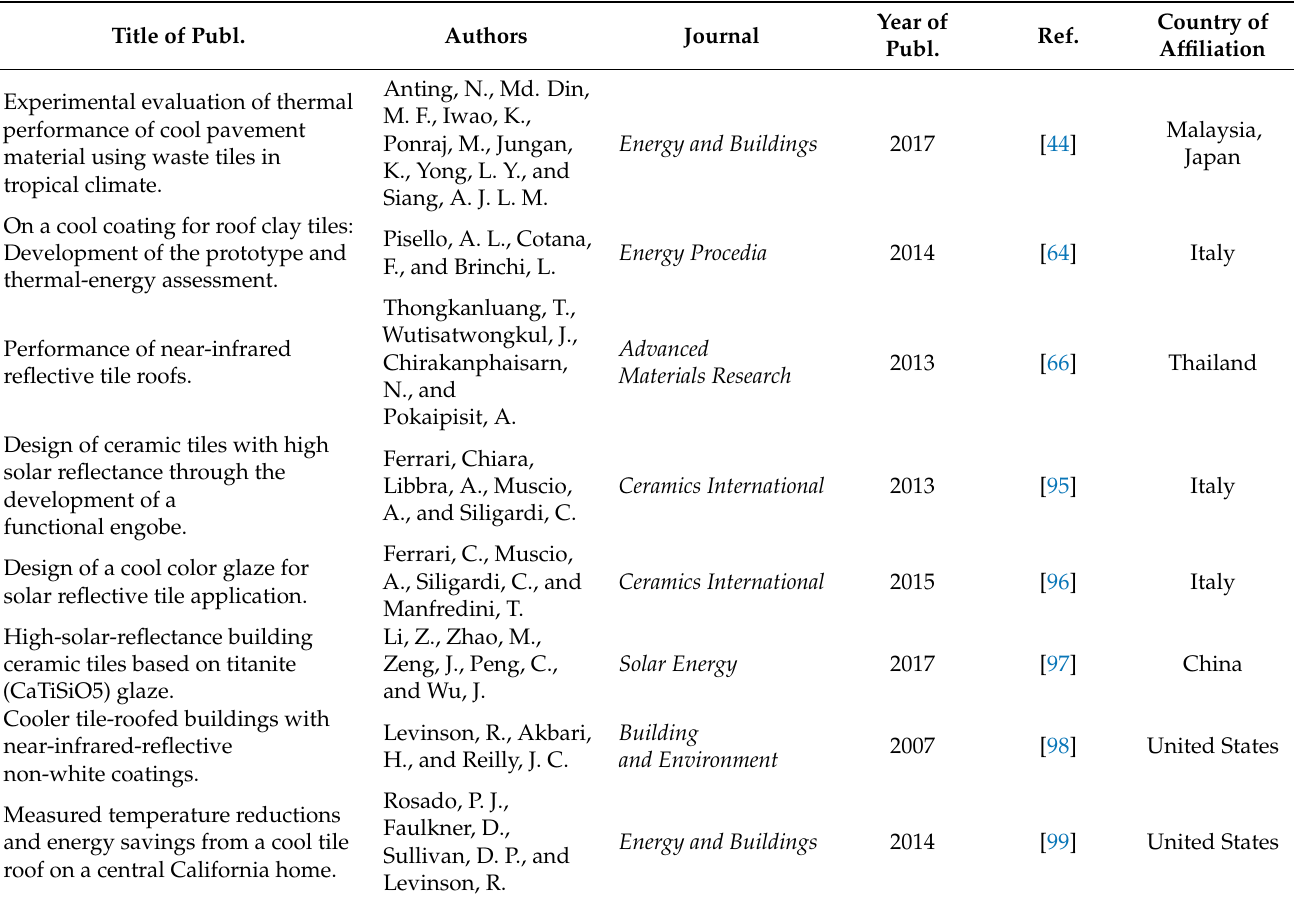
Table 4. Most important publications about ceramic